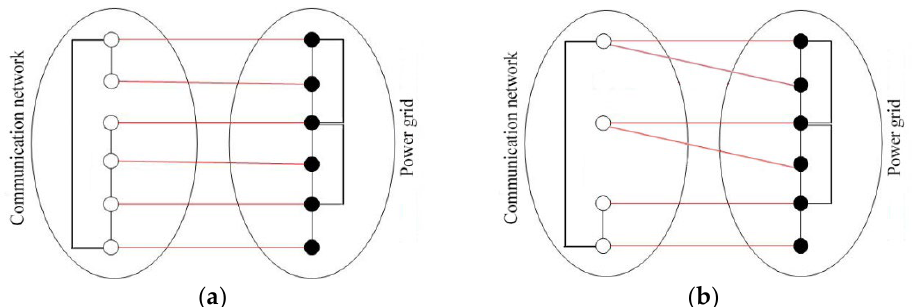
Figure 1. Two types of interdependent networks. ( a ) One-to-one correspondent interdependent network; ( b ) Partial interdependent network.